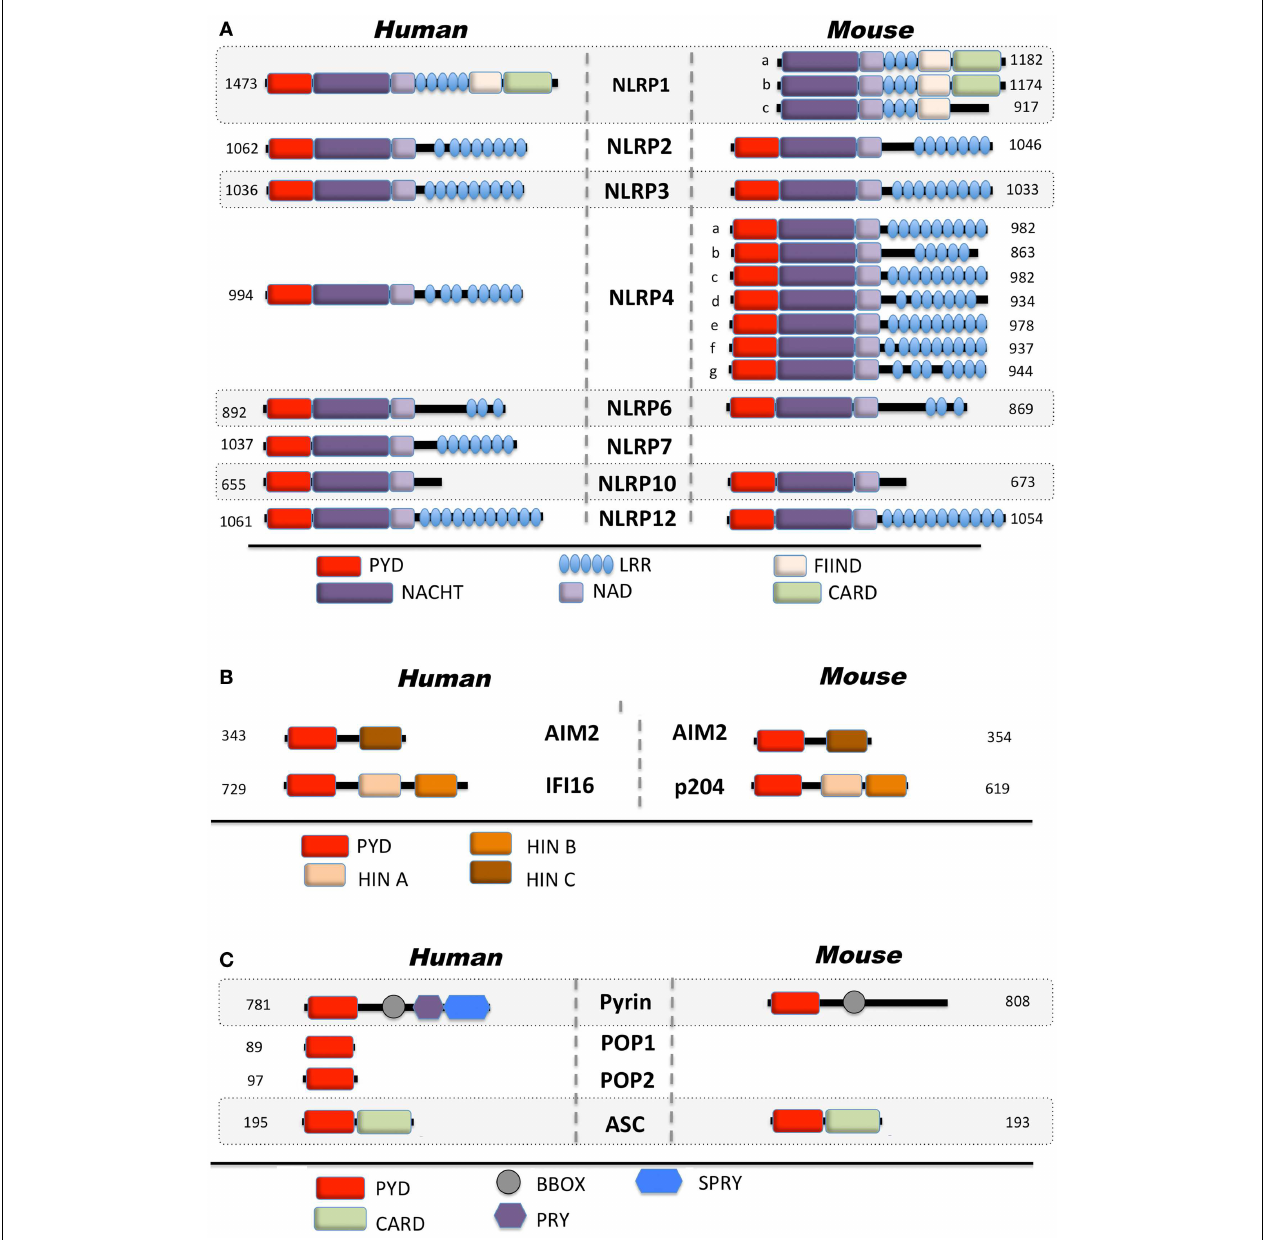
FIGURE 1 | Domain architecture of PYD-containing proteins involved in innate immunity . Depicted are human and mouse (A) Nod-like receptors, (B) AIM2-like receptors, and (C) regulatory proteins.